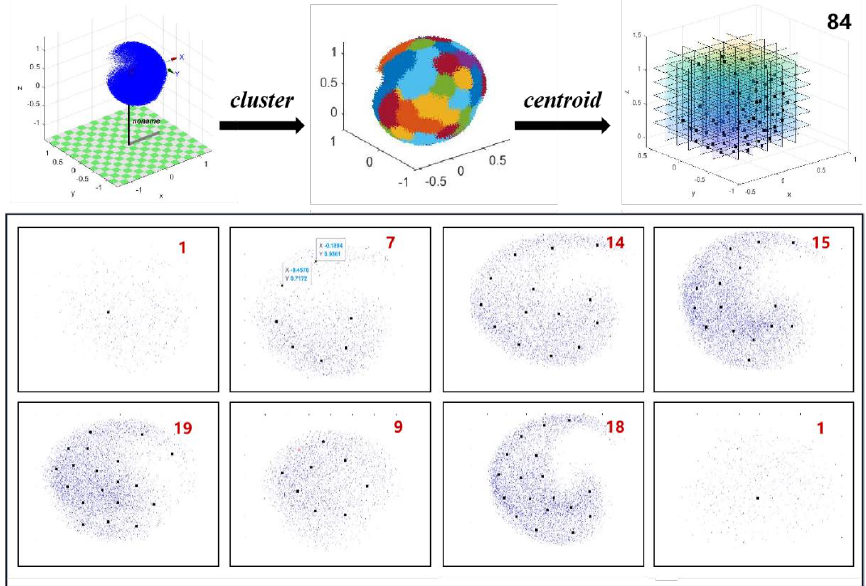
Figure A1. The results of the K-means cluster, the top figure reflects the clustering process for 200,000 points in the workspace, the bottom figure is the profile of the cluster center, and the black points represent the cluster centers, with 84.